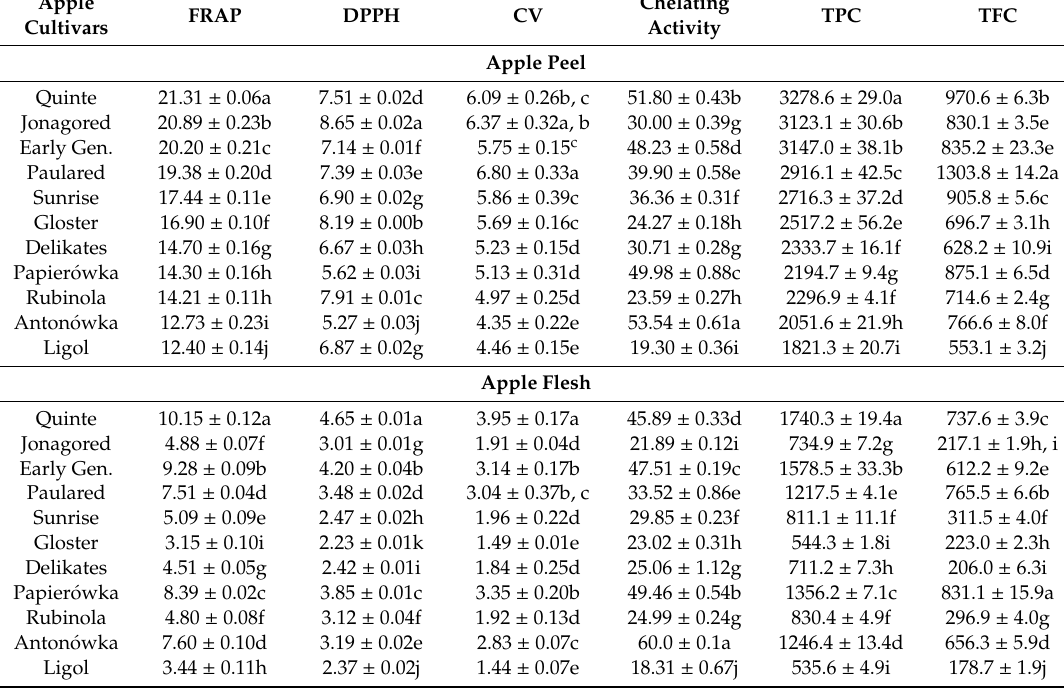
Table 2. Total phenolic content (TPC), total flavonoid content (TFC), Fe 2 + chelation activity, and antioxidant activity by ferric-reducing / antioxidant power assay (FRAP), 2,2-diphenyl-1-picrylhydrazyl (DPPH), and cyclic voltammetry (CV) of the peel and flesh of different apple cultivars. Apple